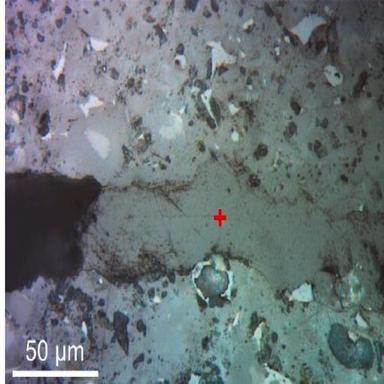
Raman spectra (a, c, e) of CH identified in cracks (red cross) shown in optical micrographs (b, d, f) from samples and CA dosages of: 0% CA (a and b); 1% CA (c and d); and 2% CA (e and f). (For interpretation of the references to colour in this figure legend, the reader is referred to the Web version of this article.)